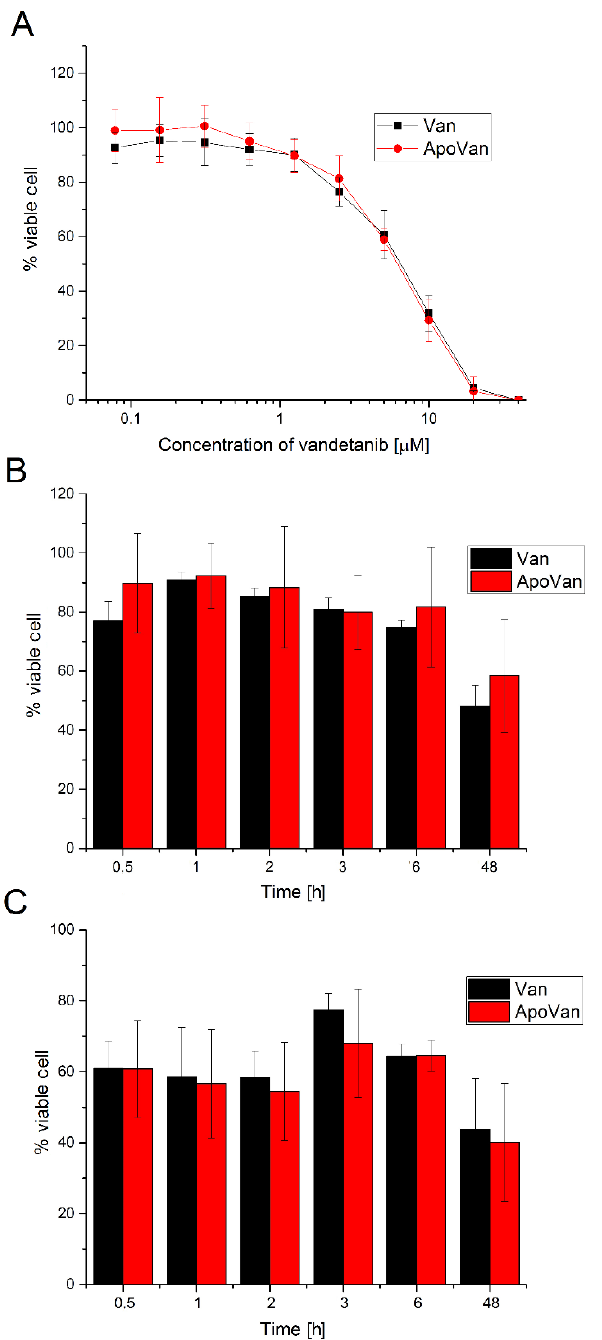
Figure 5. ( A ) The concentration dependence of free Van and ApoVan cytotoxicity in neuroblastoma cells UKF-NB-4 for 48 h. Values are mean ± SD from three independent experiments; ( B ) the time dependence of free Van and ApoVan cytotoxicity in neuroblastoma cells UKF-NB-4 for up to 48 h; ( C ) the time dependence of free Van and ApoVan cytotoxicity in thyroid carcinoma cells (TT) for up to 48 h. Values are mean ± SD from four independent experiments.